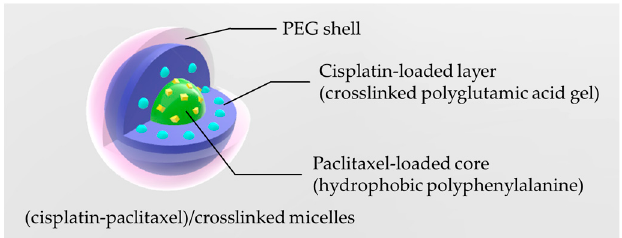
Figure 7. Structure of the nanogel micelles [30] with the expected core-layer-shell framework to host the different drugs.